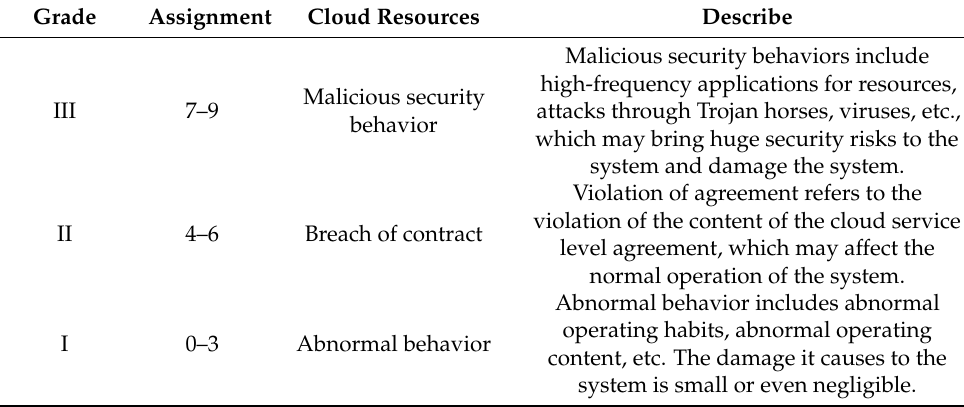
Table 4. Threat behavior